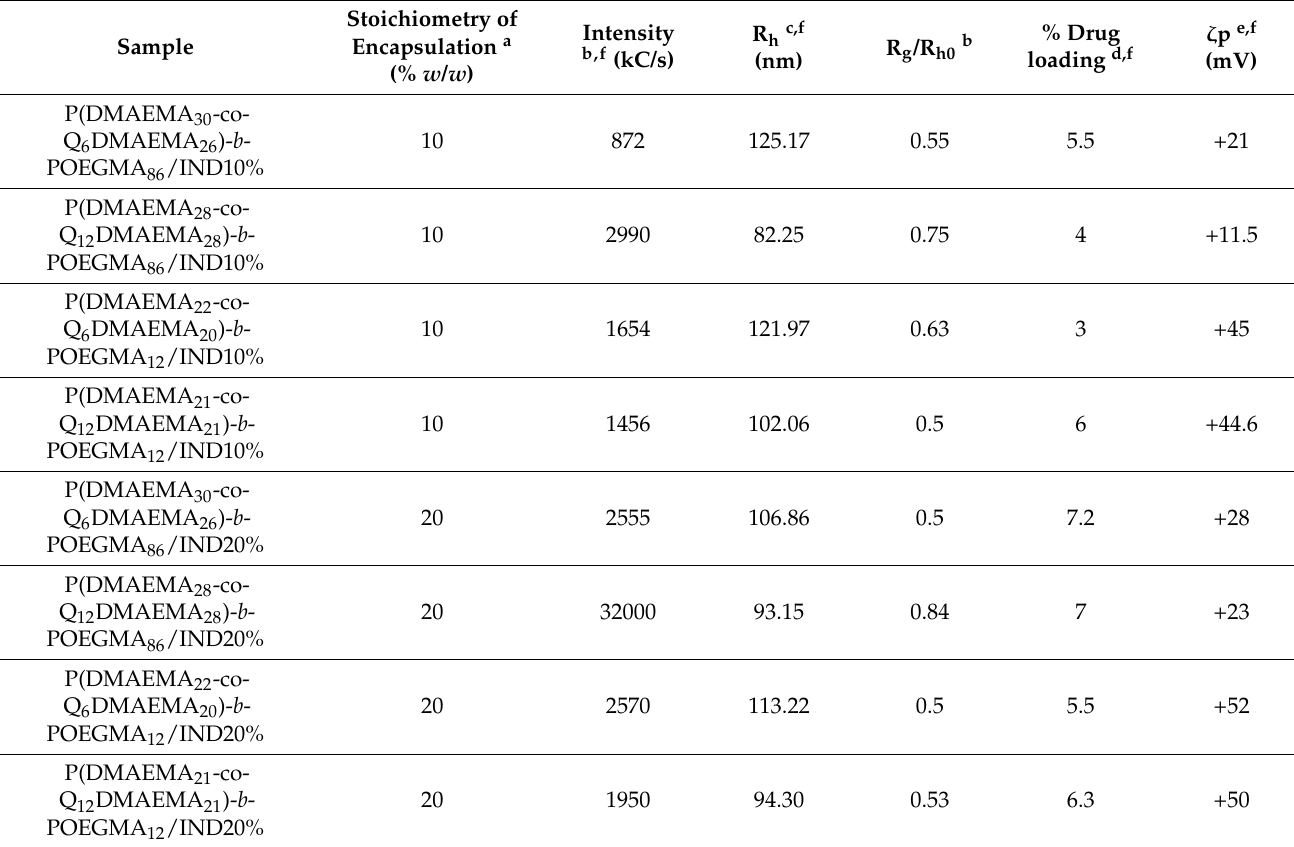
Table 7. Physicochemical characteristics of the mixed random diblock copolymers with IND and the drug loading results of all the examined mixed